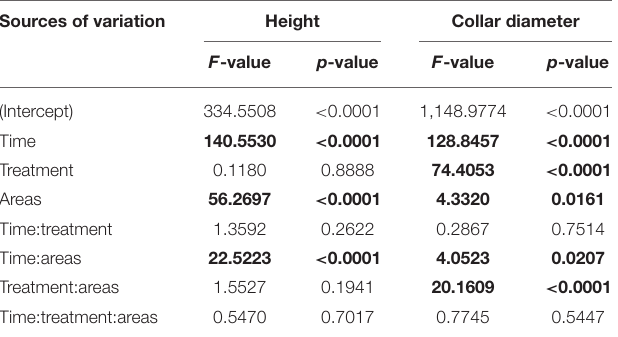
TABLE 2 | ANOVA results of height and collar diameter. Sources of